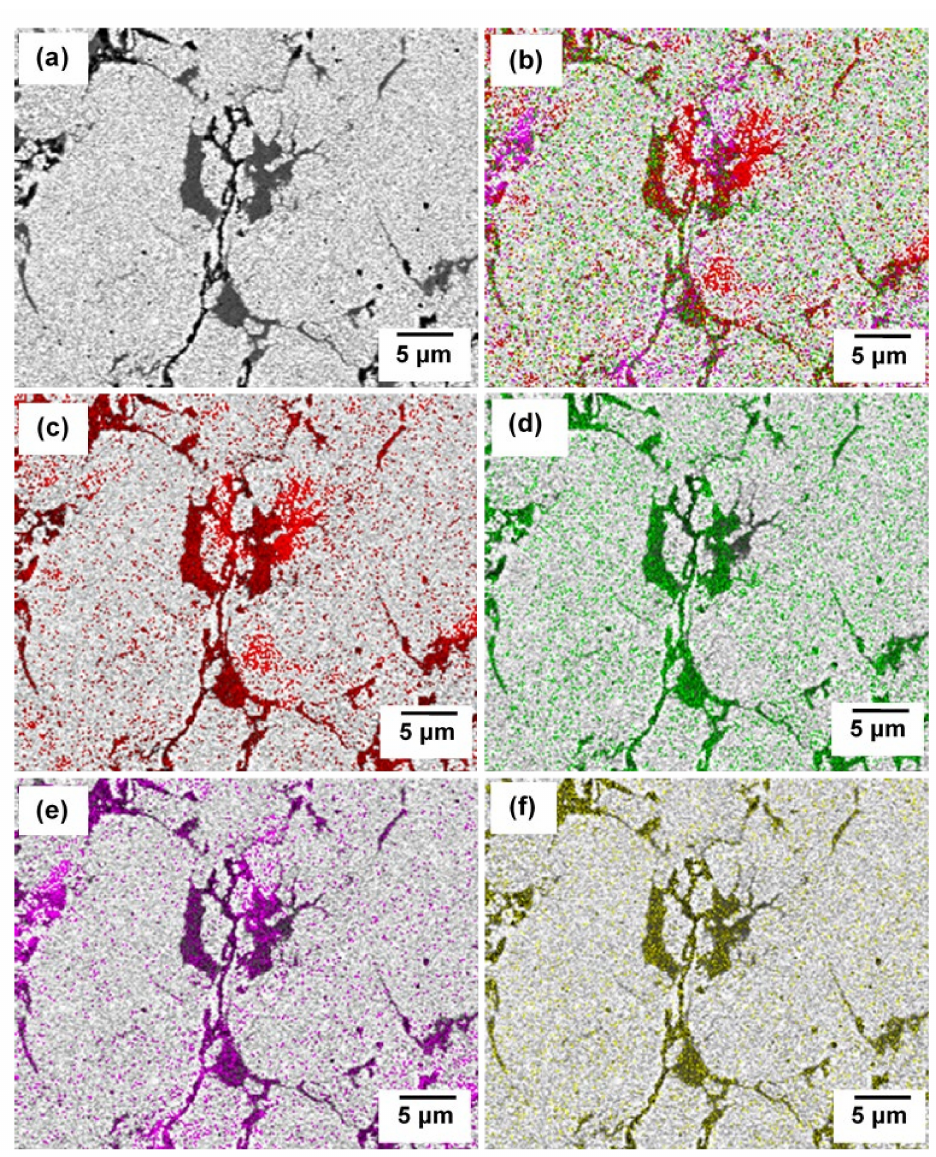
Figure 12. ( a ) SEM image and elemental mapping on the corresponding area of ( b ) all elements, ( c ) Cu (red), ( d ) W (green), ( e ) Fe (indigo) and ( f ) C (yellow) in sintered compact milled at 40 h and sintered at 900 ◦